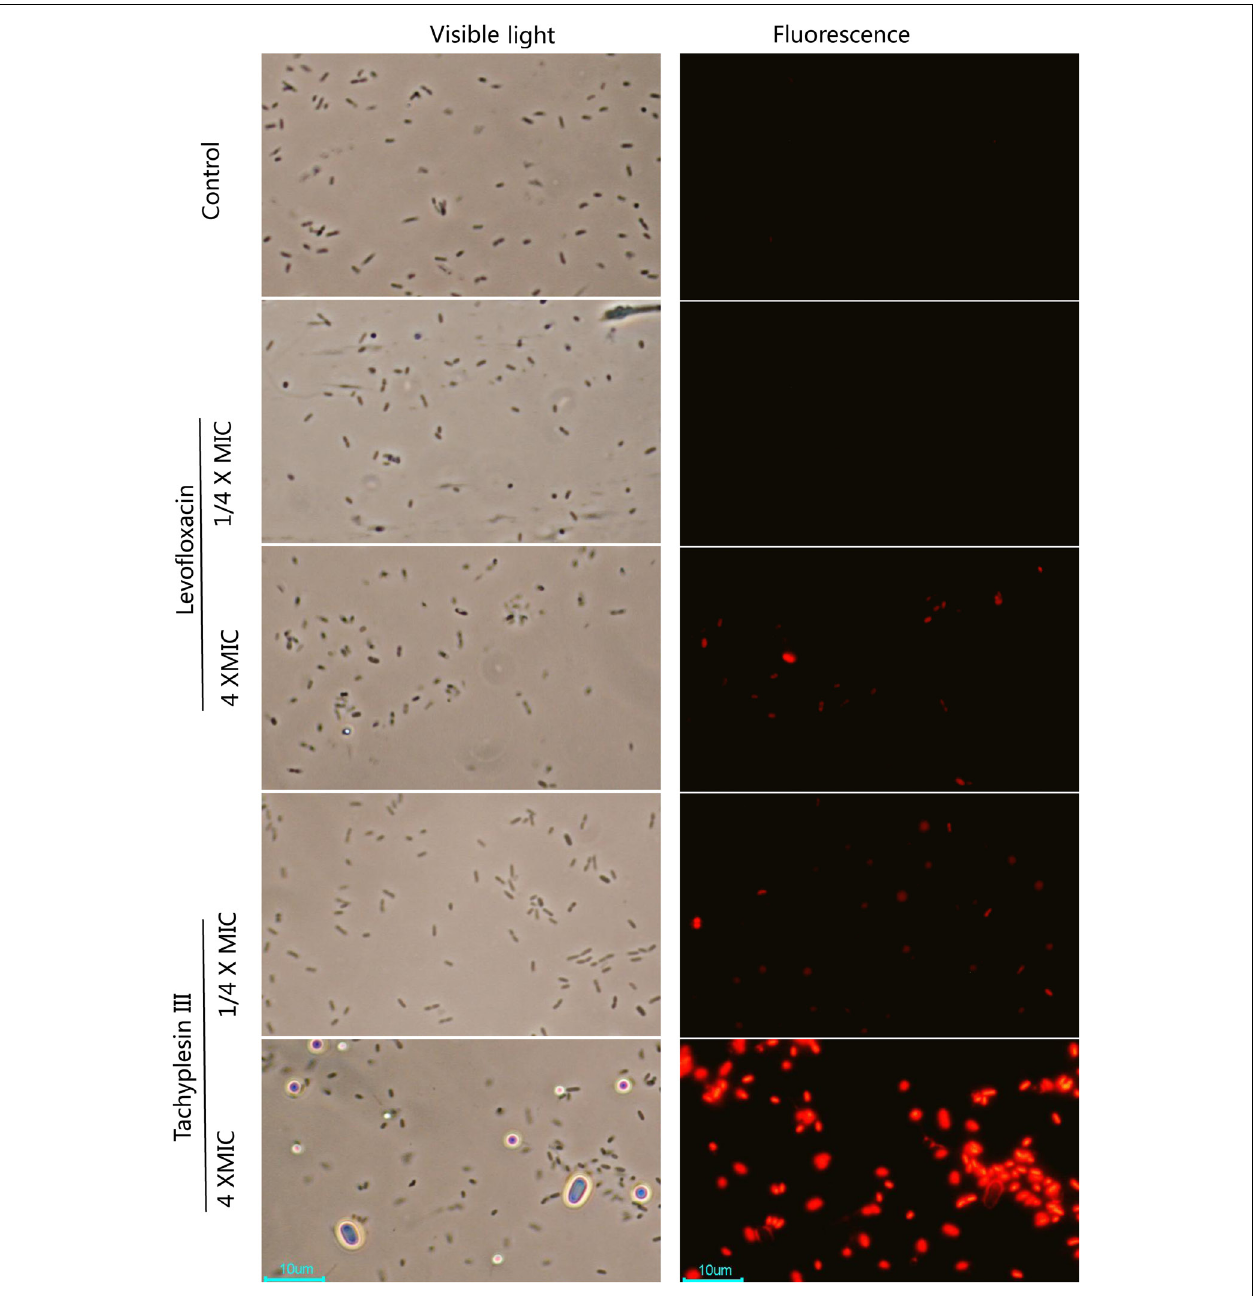
FIGURE 3 | Propidium iodide staining after treatment with levofloxacin or tachyplesin III at different concentrations. First, 1 × 10 7 MDR clinical isolates of P. aeruginosa strain 1409 were incubated with 1/4 × MIC (4 µ g/ml), 4 × MIC (64 µ g/ml) levofloxacin (Tokyo Chemical Industry Co. Ltd) or 1/4 × MIC (2 µ g/ml), 4 × MIC (32 µ g/ml) tachyplesin III in Luria-Bertani (LB) medium at 25 ◦ C for 1 h. After centrifugation at 3000 g for 10 min, cells were resuspended in the same volume of PBS (phosphate-buffered saline, 8 g/L NaCl, 0.2 g/L KCl, 1.44 g/L Na 2 HPO 4 , 0.24 g/L KH 2 PO 4 , pH 7.4). Then, PI was added to a final concentration of 10 µ g/ml. After 30 min of incubation at 25 ◦ C, the cells were washed three times with PBS and immediately imaged with a fluorescence